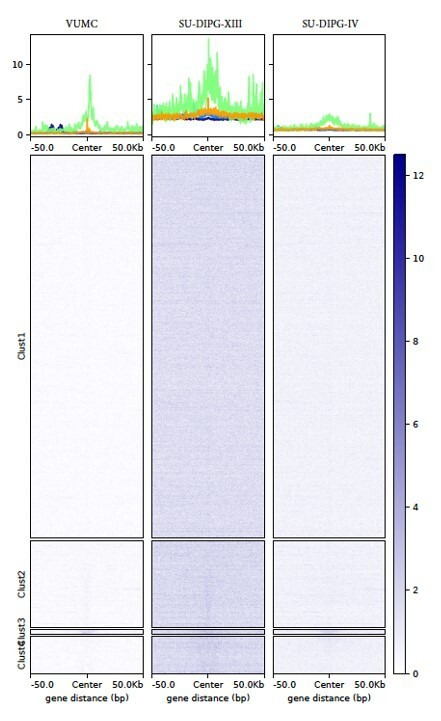
Enrichment of EZH2 in H3K27me3 domains.CUT&RUN signal for EZH2 (blue) in differential H3K27me3 domains defined in Figure 4A.